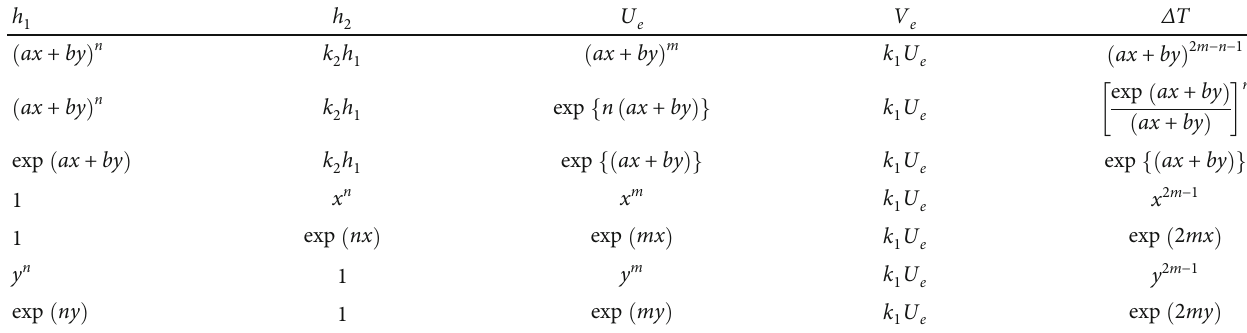
Table 1: Similarity requirements in curvilinear